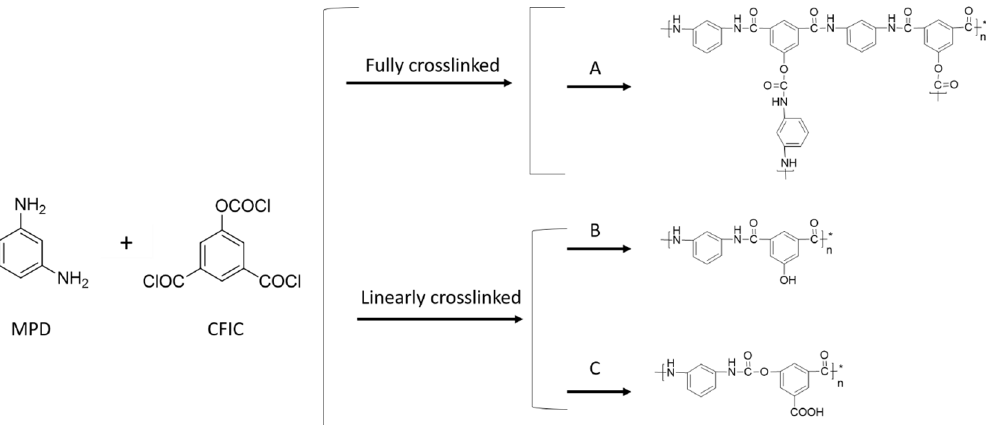
Figure 4. Typical chemistry for interfacially formed PAUt membranes. A to C represented the ideal chemical structure of resultant PAUt selective separation layer formed by MPD and CFIC. Table 1. Elemental composition of the possible ideal structure and the actual data of XPS analysis for PAUt membranes.